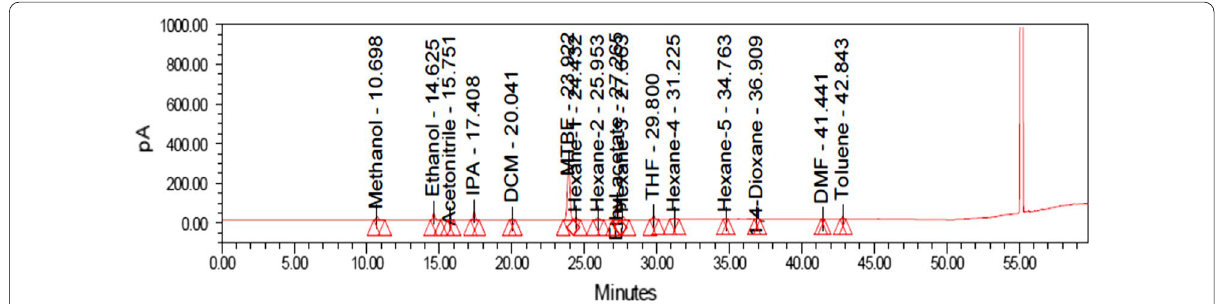
Fig. 2 Typical chromatogram for Twelve organic volatile